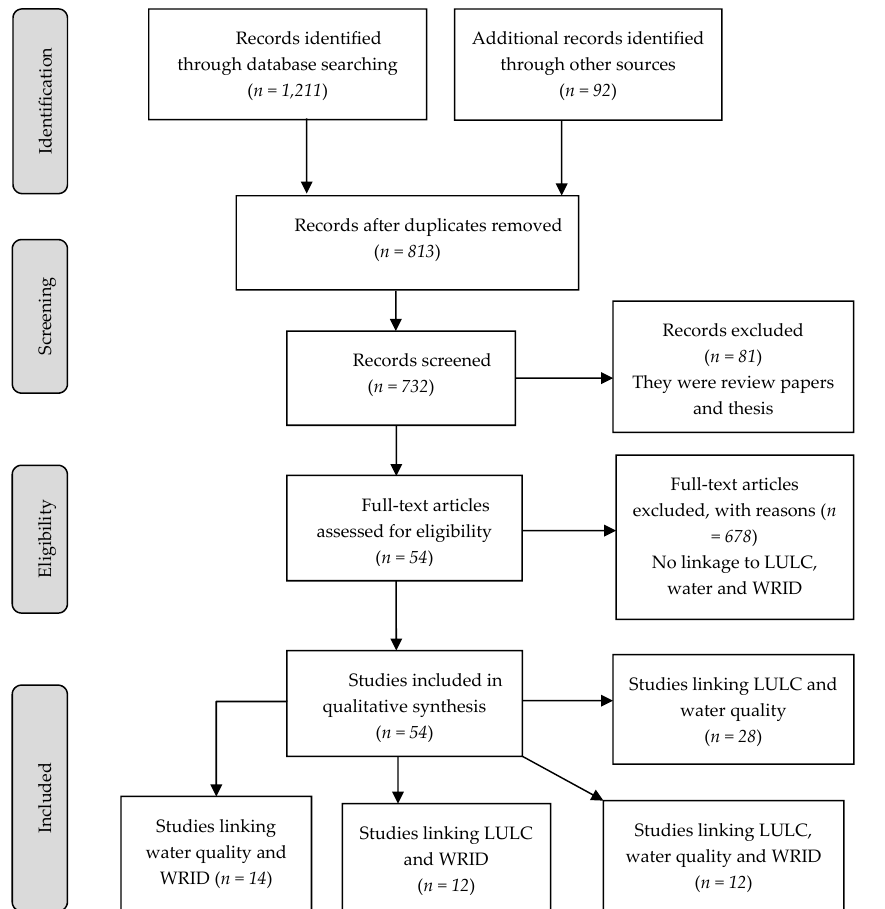
Figure 2. PRISMA flow diagram for the selection of the eligible studies Source: Adapted from [48].